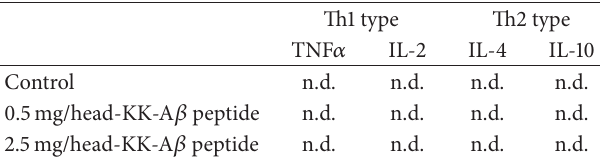
Table 1: Cytokines in the peripheral blood of cynomolgus monkeys.